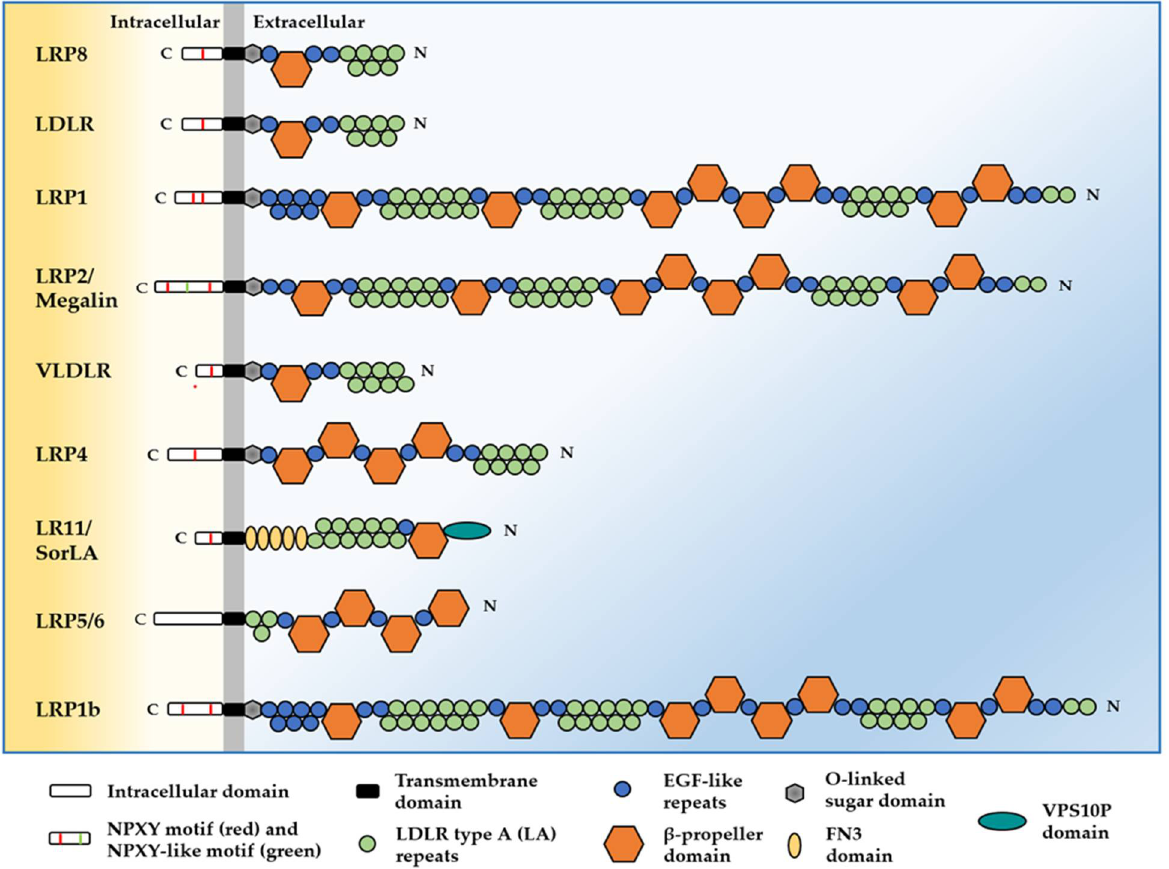
Figure 1. The domain structure of the LDL family members: differences and similarities. LDLR, VLDLR, and LRP8 are made of seven LA repeats in the ligand-binding domain, three EGF-like domains, and one YWTD β -propeller. LRP1 and LRP2 have the largest extracellular domains, each with eight YWTD β -propellers spaced by EGF and LA repeats. LRP4, LRP5 and LRP6 carry high sequence homology to a region within LRP1 with YWTD β -repeats going three through six. SorLA has two additional domains: the FNIII domain and the VPS10 domain. Regarding the NPxY motif, VLDLR, LRP8 and LR11/SorLA-1A have a single copy, whereas LRP1 and LRP1B contain two copies and LRP2/Megalin three copies. No NPXY is present in LRP5 and LRP6. Domains are not drawn to